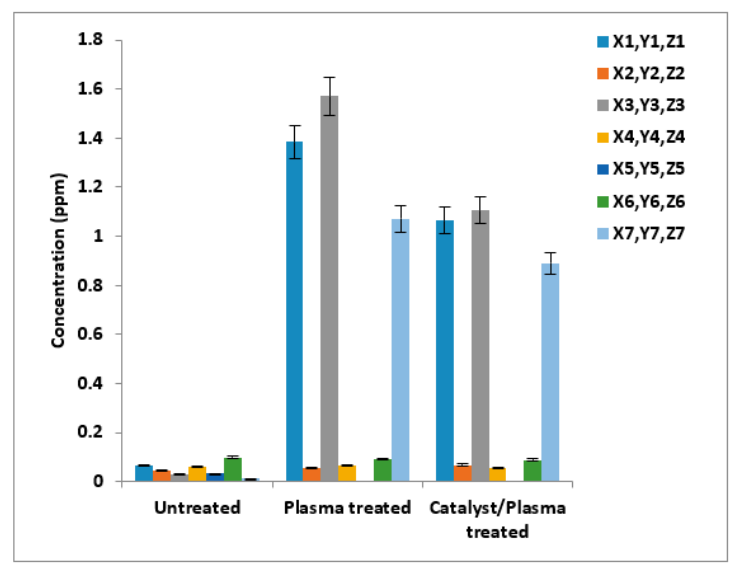
Figure 5. Cu concentration in untreated and plasma-treated water samples.